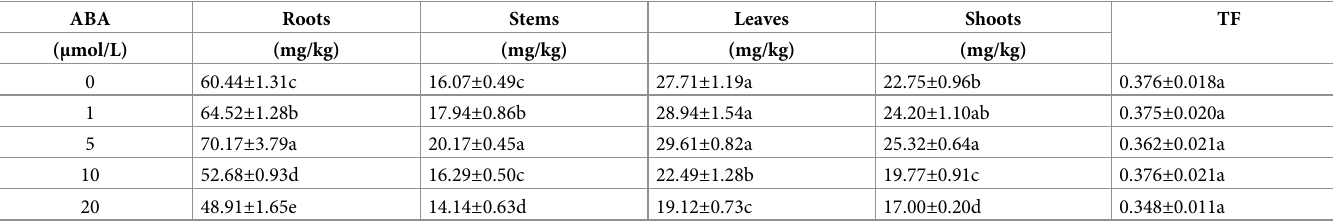
Table 4. Se content in P . frutescens .